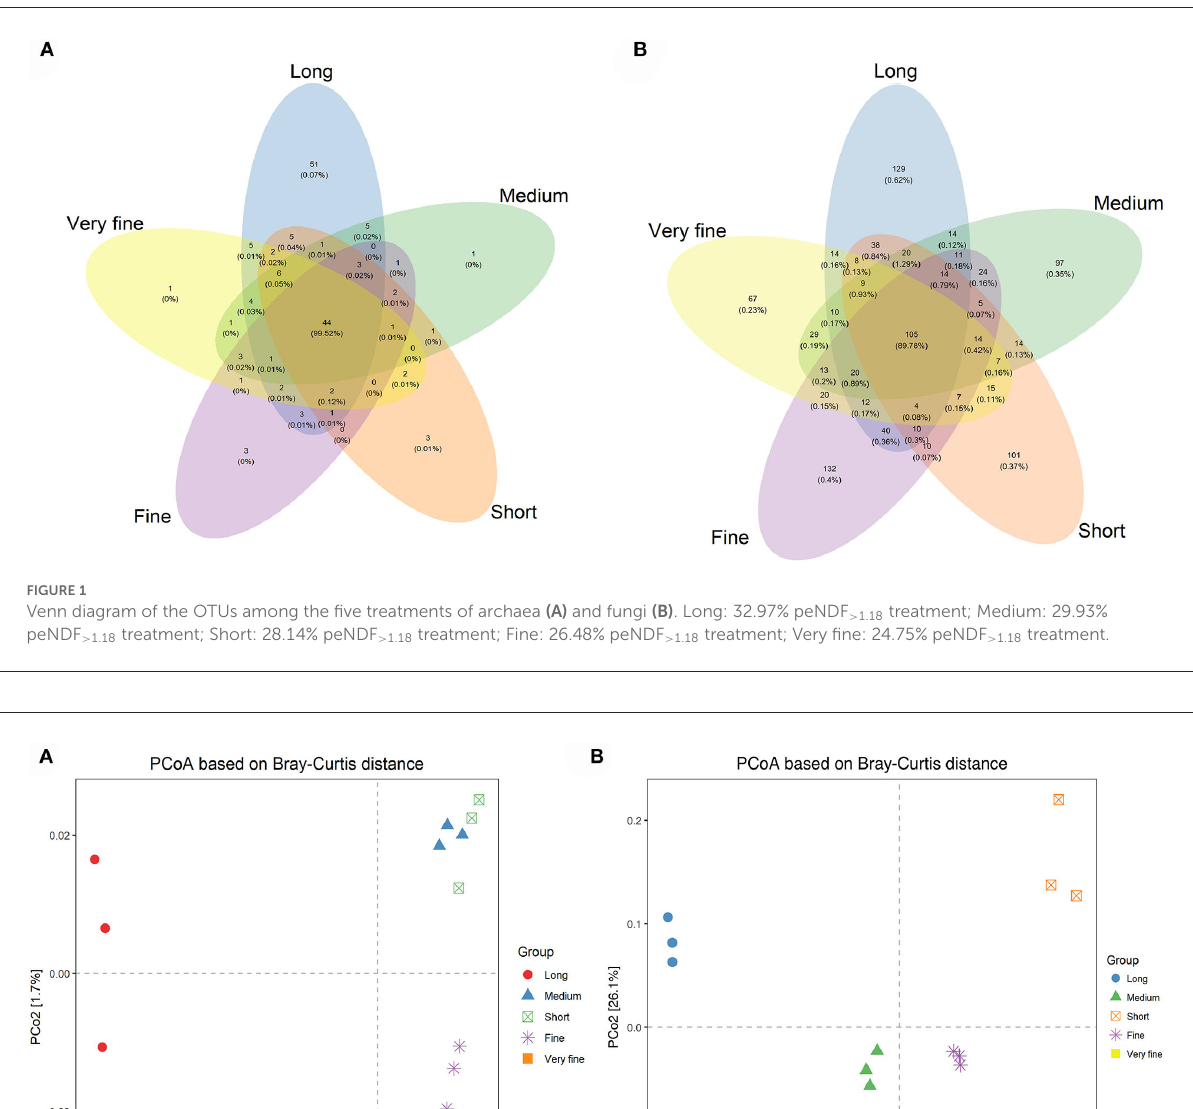
The principal co-ordinate analysis (PCoA) was conducted based on the Euclidean distances between the different treatments, and the results are shown in Figure 2B. Each treatment was evenly distributed among the clusters. All samples tended to cluster together in accordance with their own ration